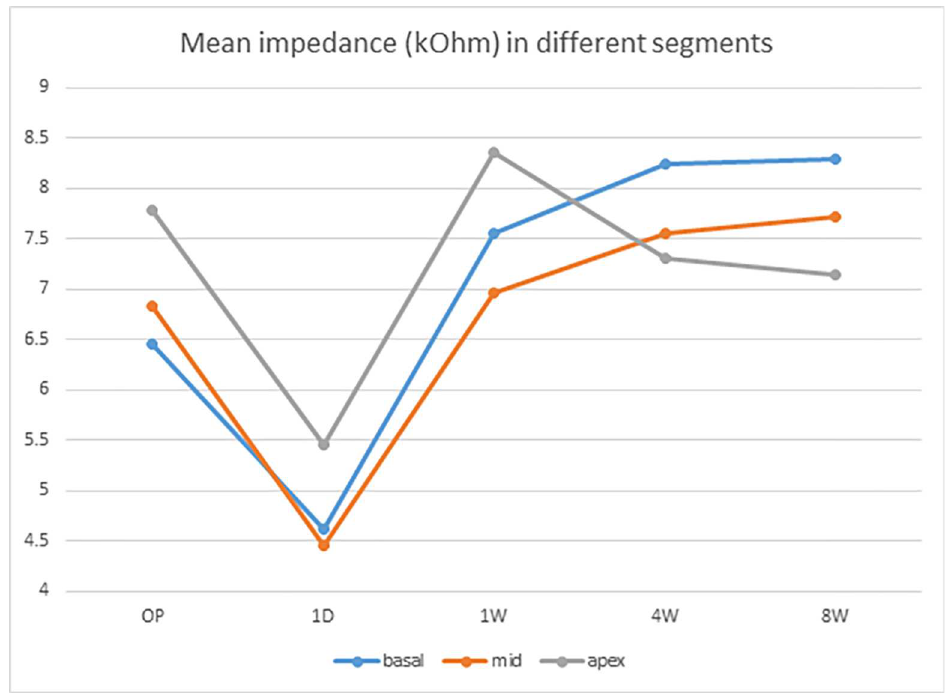
Fig 3. Evolution of mean impedance of the apical, mid-portion and apical electrodes over 8